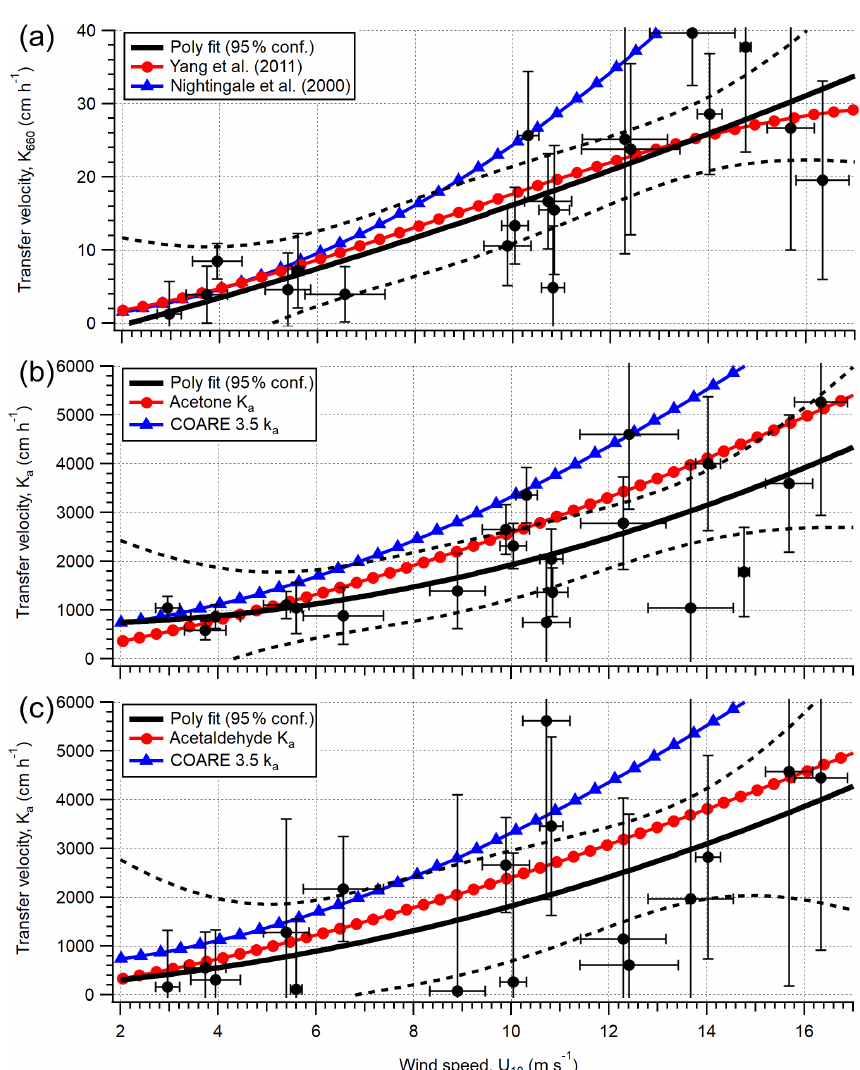
Figure 7. Calculated transfer velocities (hourly) for (a) DMS ( K w , 600 ), (b) acetone ( K a ) and (c) acetaldehyde ( K a ) in the open-water foot- print of the Penlee Point Atmospheric Observatory during the dates 27 April–3 May 2018. Error bars on the experimental data (black circles) are propagated uncertainty from the eddy covariance measurement. The black poly fit lines are fit to the experimental data, with the dashed black lines representing 95% confidence in the poly fit. The red circle and blue triangle lines in panel (a) are theoretical transfer velocities using the k w parameterisations of Yang et al. (2011a) and Nightingale et al. (2000) respectively. The red circle lines in panels (b) and (c) are theoretical transfer velocities calculated from the k w parameterisation of Yang et al. (2011a) and k a from the COAREG 3.5 model (shown as blue